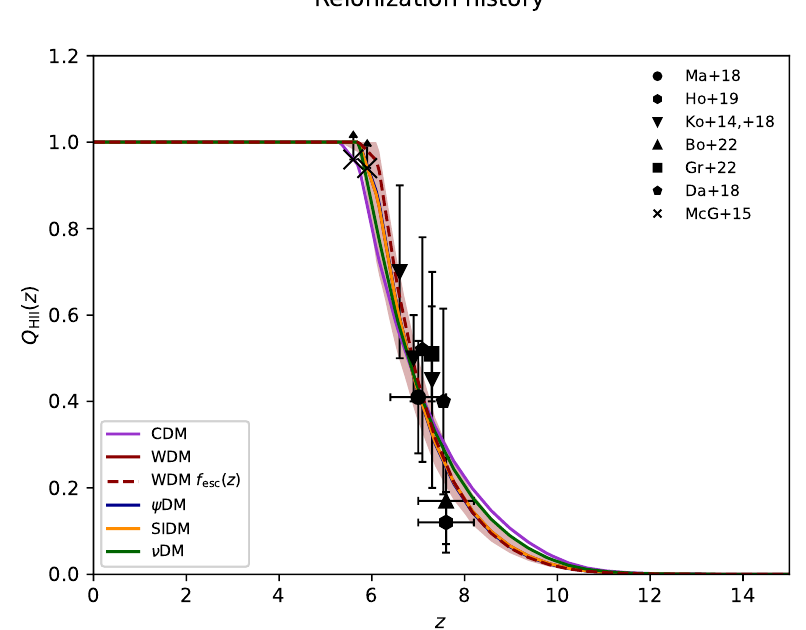
Figure 12. The reionization history of the Universe, in terms of the volume filling fraction Q HII of ionized hydrogen as a function of redshift z . Data are from [121] (circle), [123] (hexagon), [118,122] (inverted triangle), [124] (triangle), [125] (squares), [120] (pentagon), and [119] (crossed). Lines as in Figure 10.